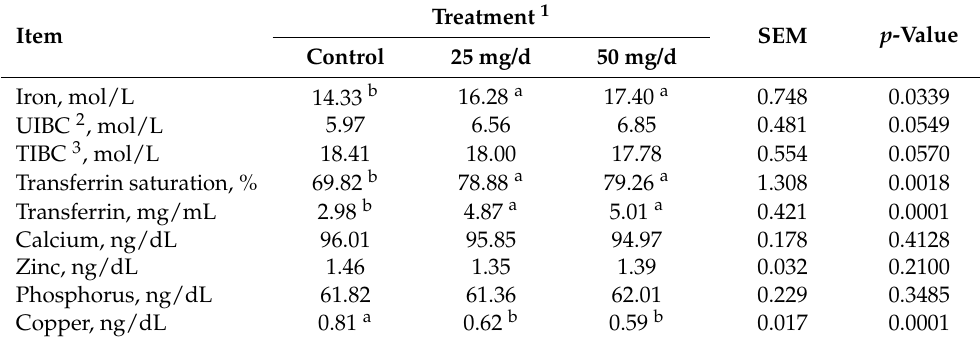
Table 3. The effect of organic iron supplementation on iron metabolism parameters and other